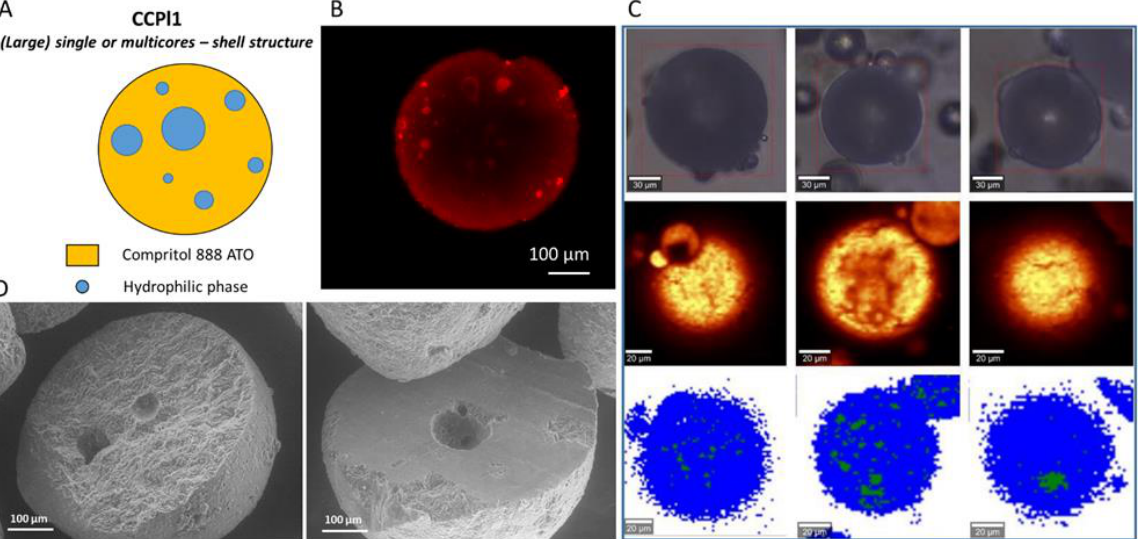
Figure 7. Internal morphology of CCPl1 b-MPs. Schematic illustration of particle structure ( A ). CLSM images, Rho (red color) solubilized in the hydrophilic phase was used as a fluorescent probe ( B ). Raman mapping images. The first row (at the top) shows visible pictures; the second row shows Raman images obtained based on the integration of characteristic Raman bands at 2852 and 2886 cm − 1 ; the third row shows Raman images: lipophilic phase (blue area) and hydrophilic phase (green area) ( C ). SEM images of cross-sections of CCPl1 b-MPs ( D ).